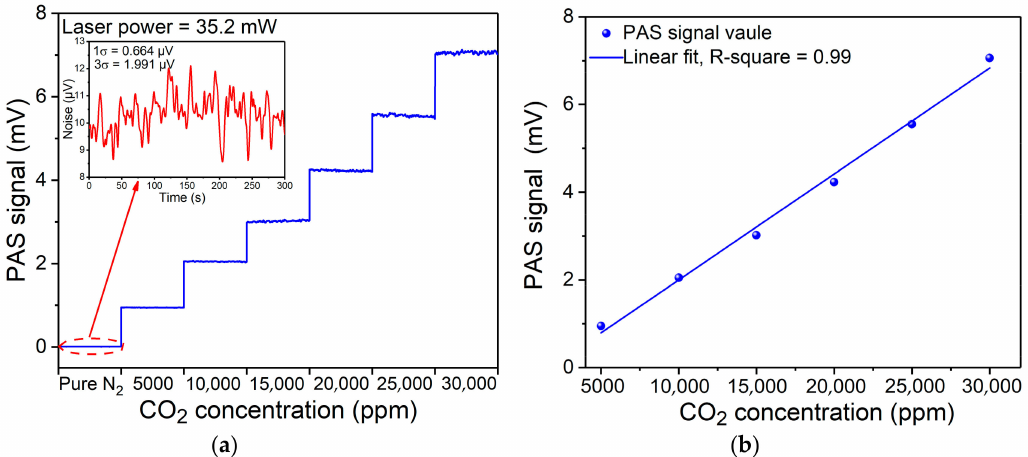
Figure 5. ( a ) System noise and PAS signal for di ff erent CO 2 concentration levels. ( b ) PAS signal as a function of CO 2